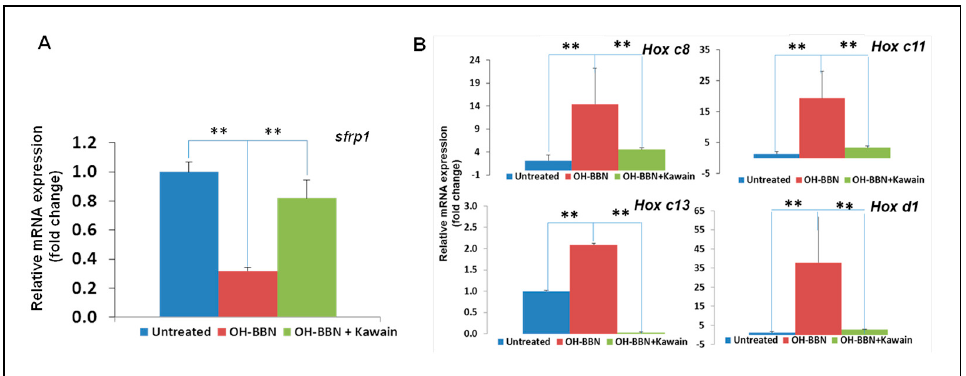
Figure 6. The kawain diet reverses the effects of OH-BBN on the expression of LSD1 target genes. ( A ) RNAs were extracted from bladder tissues of untreated, exposed to OH-BBN only, or OH-BBN plus the kawain diet mice. ( B ) Real-time RT-PCR was performed to analyze the mRNA expression of LSD1 target genes (PSA and TMPRSS2). Bars are the means ± SD of three independent experiments. The differences in mRNA expression levels were compared between OH-BBN only treatment and untreated or OH-BBN plus kawain-treated mice ( n = 6 in each group). “**” denotes p < 0.01.